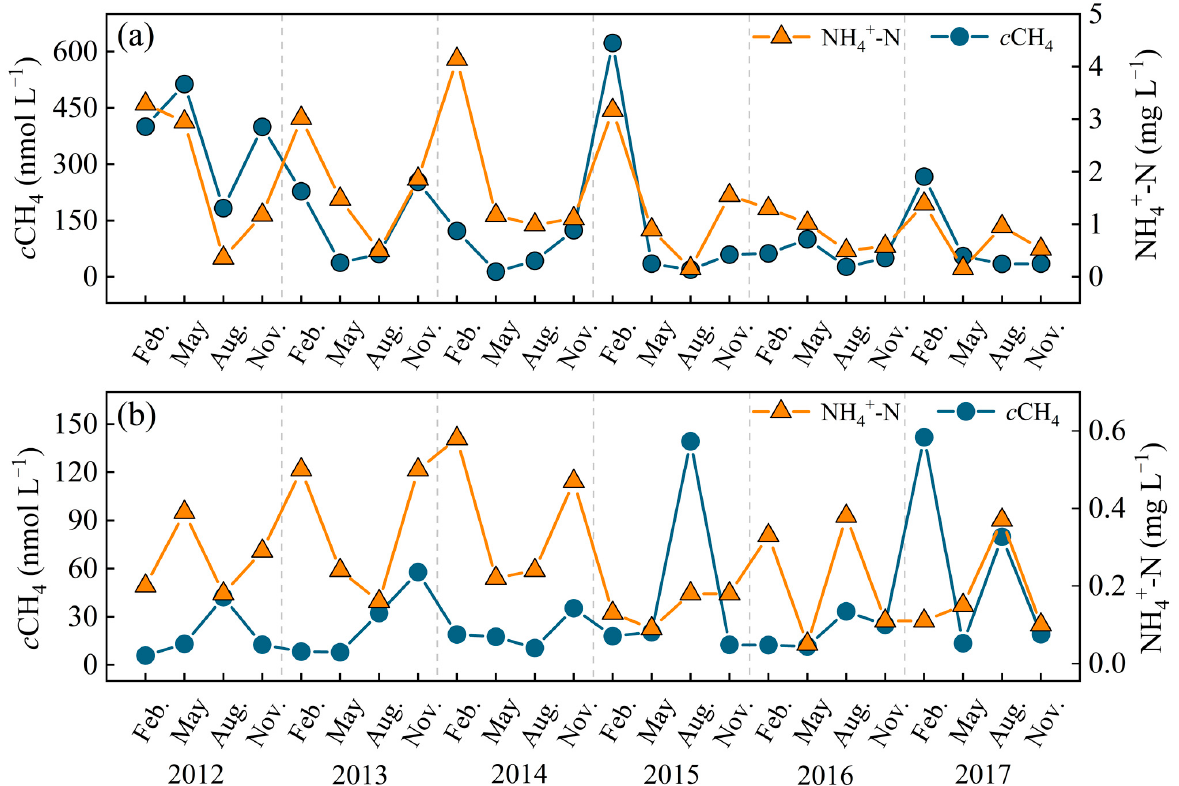
Figure 6. Trend of NH 4+ -N concentration and dissolved CH 4 at Site B ( a ) and Site C ( b ) from 2012 to 2017.